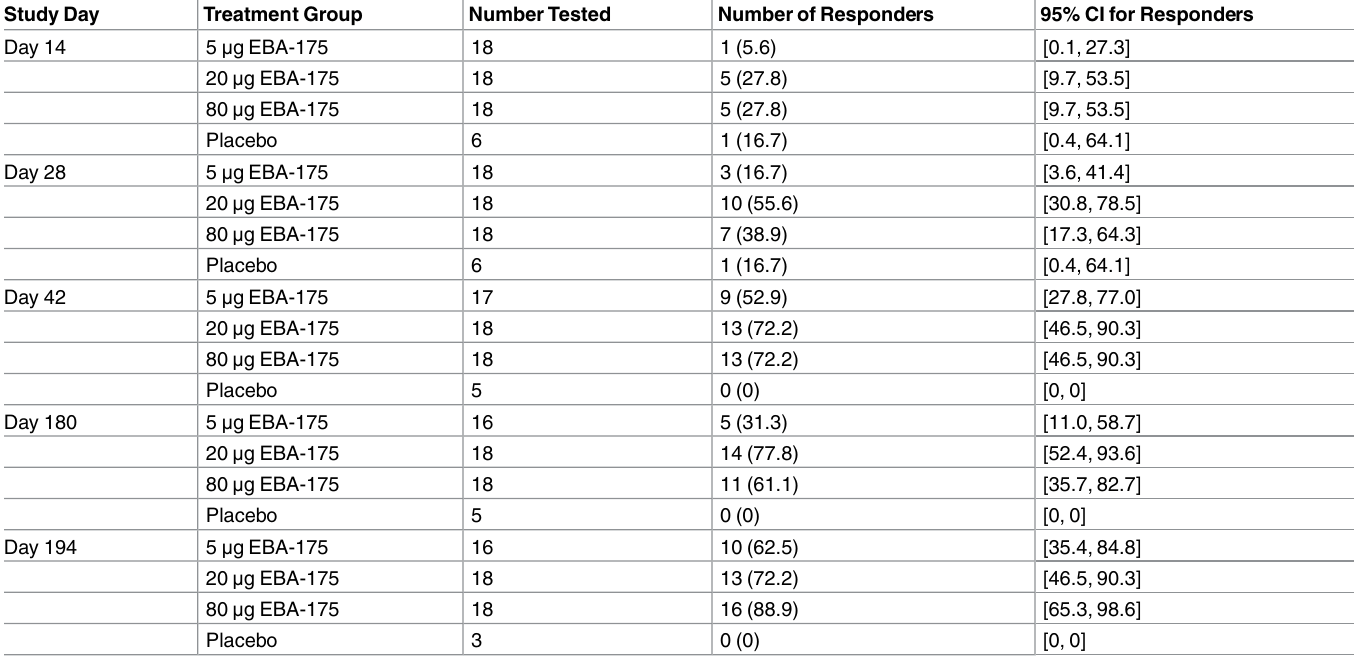
Table 3. Proportionof subjectswith4-foldincreasefrom baselinein anti-EBA175 antibodyresponse. Study Day Treatment